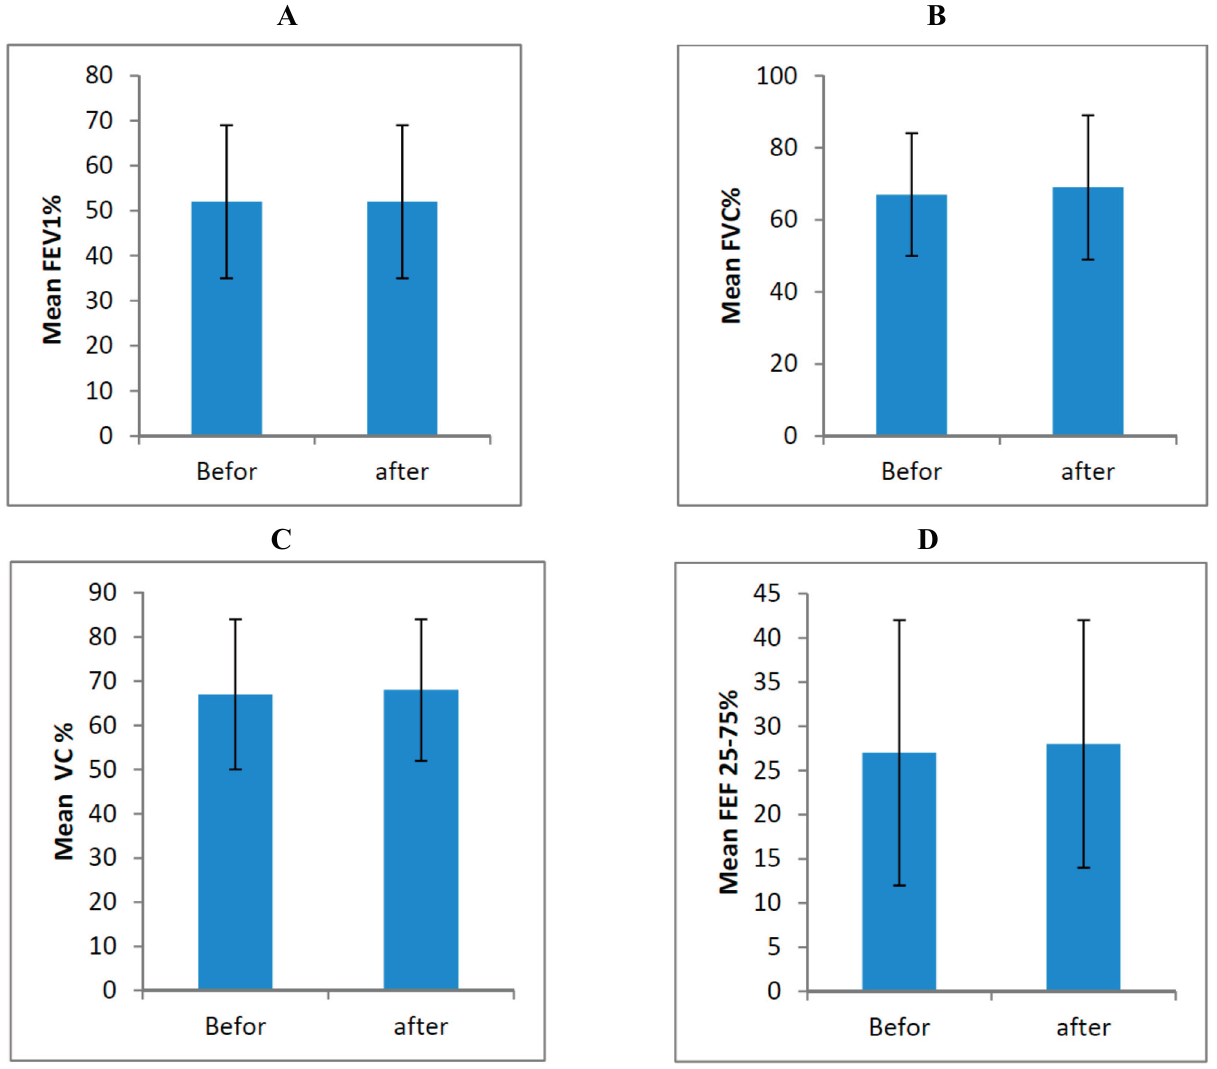
Figure 1. Means of FEV1 ( A ), FVC ( B ), VC ( C ) and FEF 25%–75% ( D ) before and after